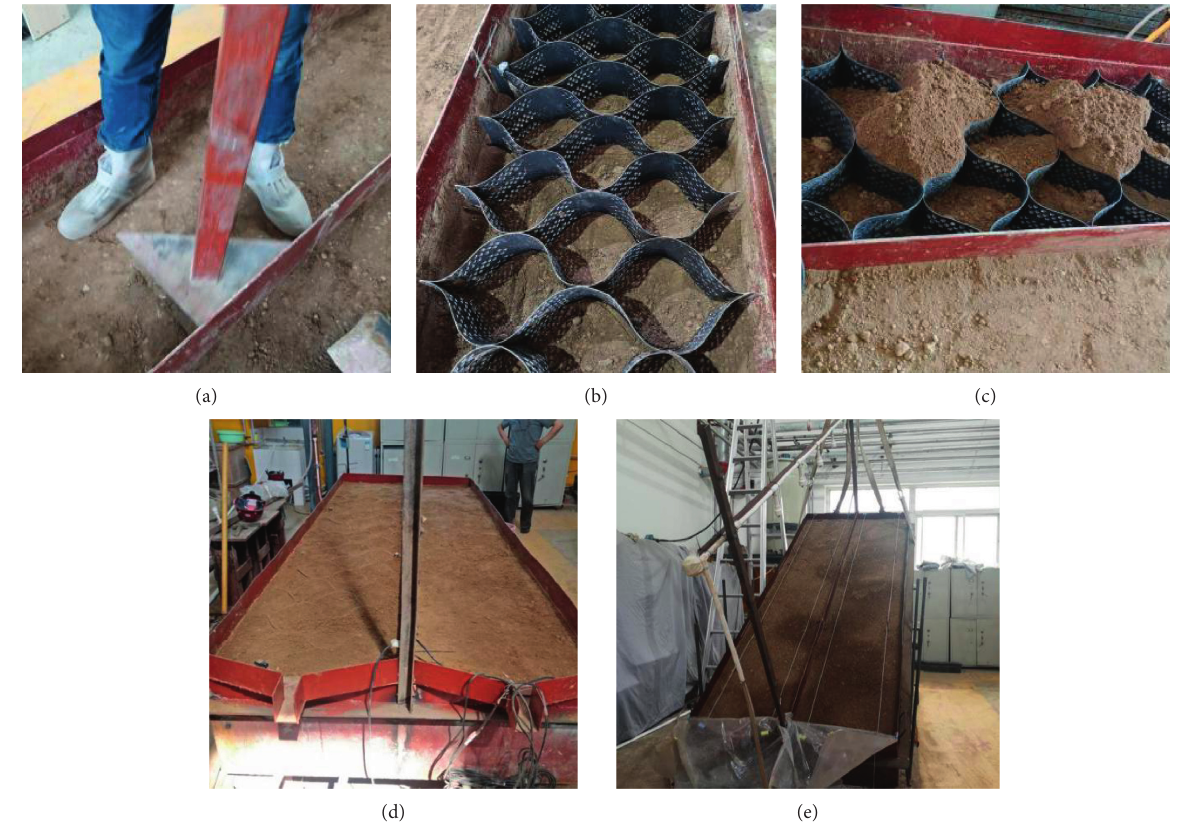
Figure 3: Model construction: (a) compaction of base soil; (b) placement of geocells; (c) fill of slope soil; (d) finished model; (e) finished model at a slope ratio of